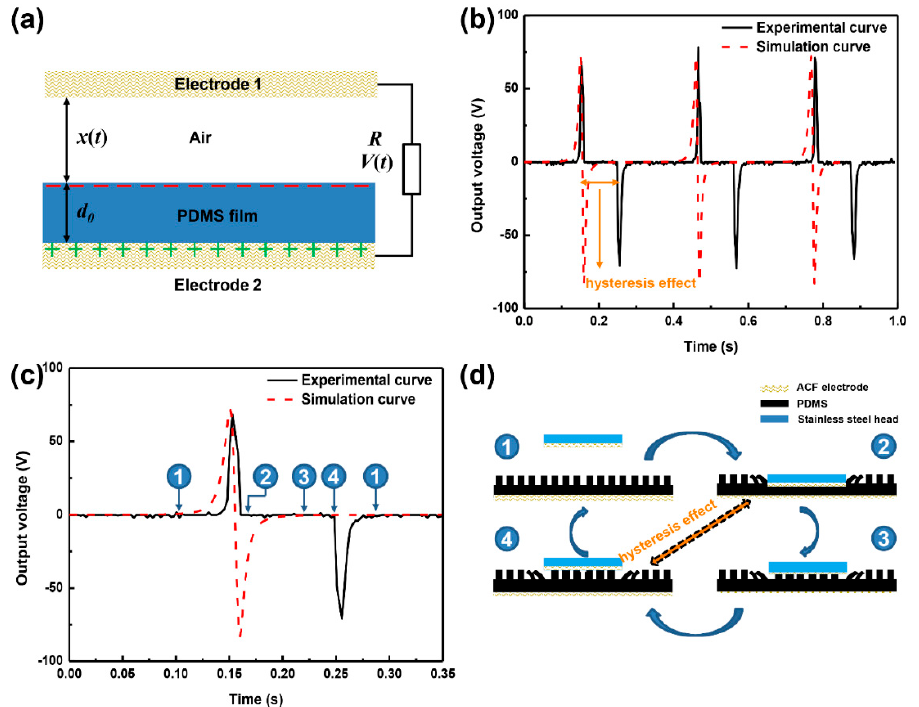
Figure 10. Comparison of experimental and theoretical prediction; ( a ) Output voltage vs. time curves. ( b ) Rectified output voltage vs. time curves. ( c ) Magnified image of voltage vs. time curve in one loading-unloading cycle. ( d ) Illustration of the corresponding reason of hysteresis effect.